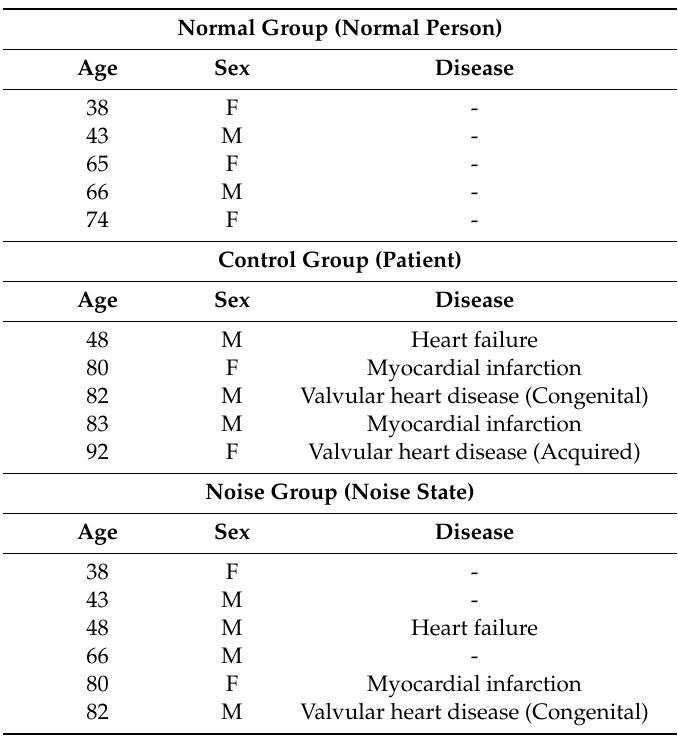
Table 2. Record ECG data collected in three classes.